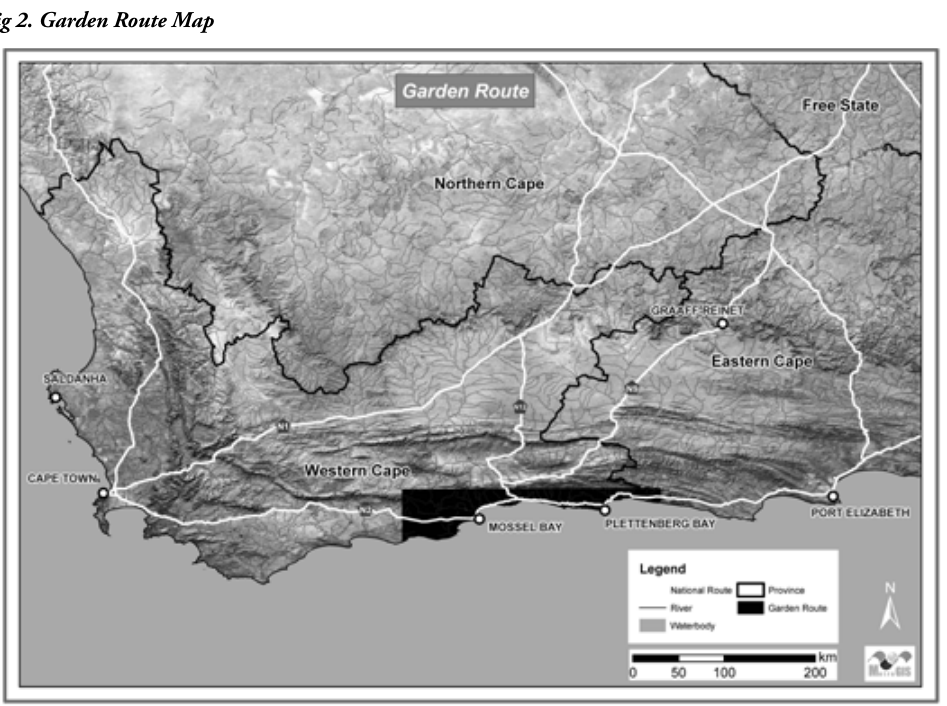
Fig 2. Garden Route